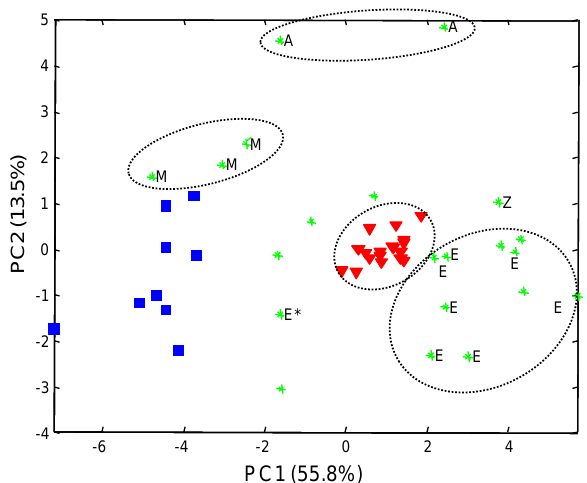
Figure 5. Map of scores of PC1 versus PC2 of turmeric and curry samples based on curcuminoid fingerprints at 420 nm. Conditions: Chromatographic method B, working time window 6 to 22 min, data dimension 30 × 2493. Sample assignment: Star = turmeric sample; square = curry sample; triangle = quality control. Variety assignment: E = Erode; M = Madras; A = Allepey; Z = Zeodaria.